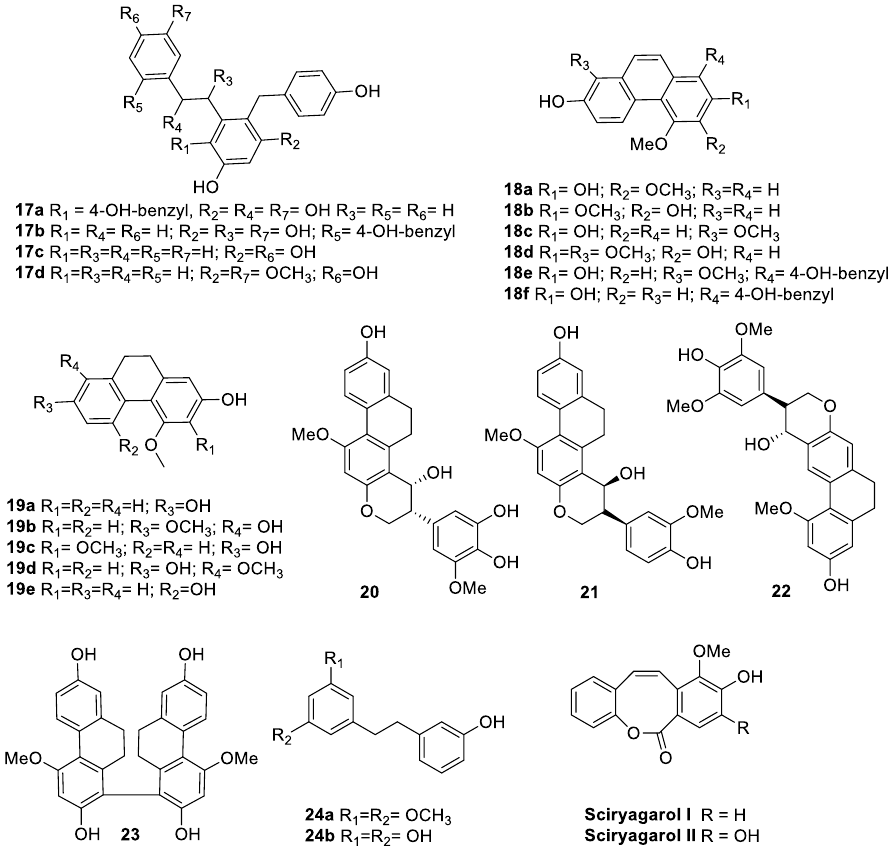
Figure 9. Structures of compounds extracted from Bletilla striata from Jiang et al. (2019) [74] and Scirpus yagara Ohwi from Liang et al . (2013) [76]. Table 13. Minimum inhibitory concentrations (MICs) for selected compounds isolated from Bletilla striata from Jiang et al. (2019) [74].